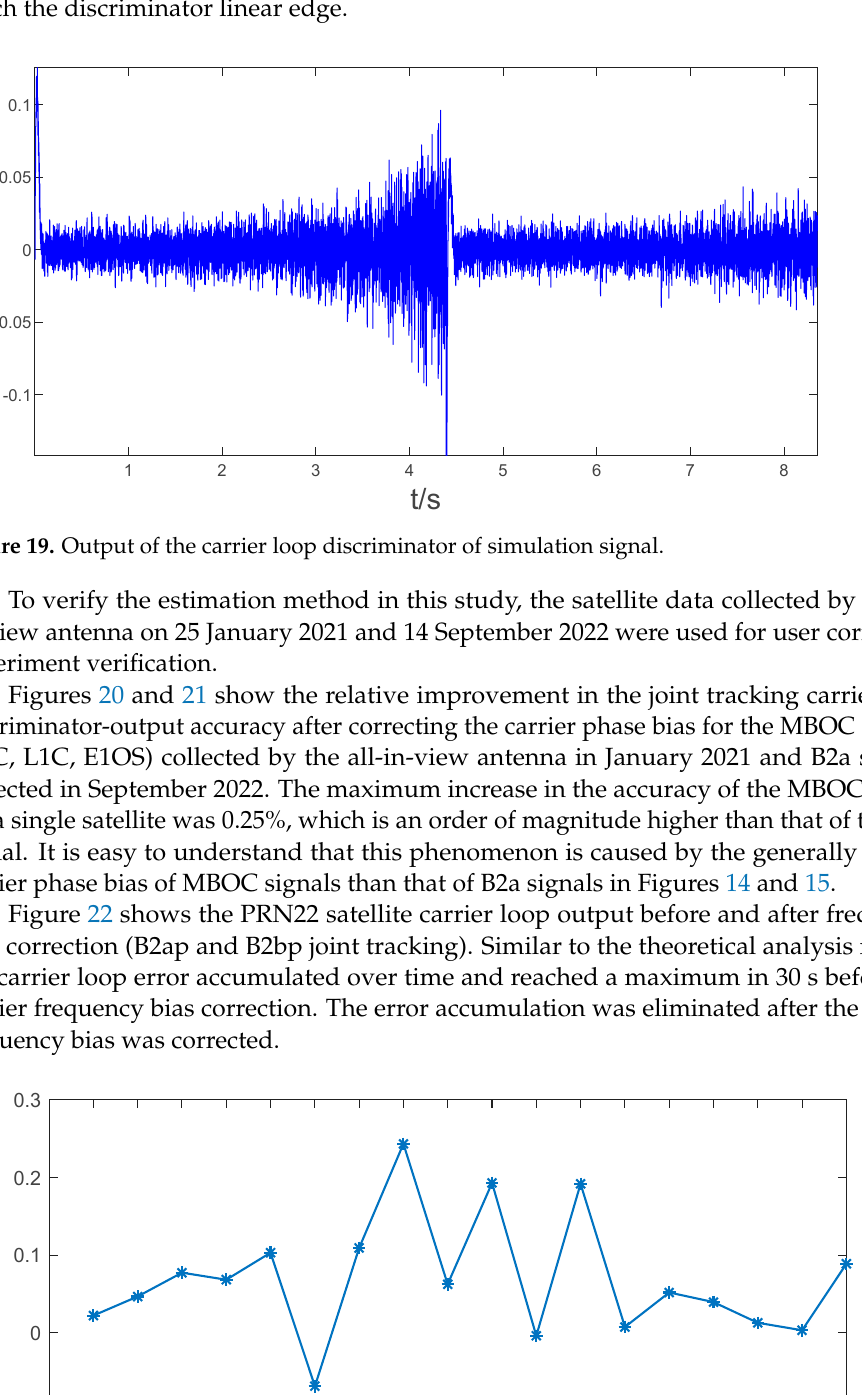
20 of 26 Figure 18. Standard deviation of carrier loop discriminator of simulation signal.